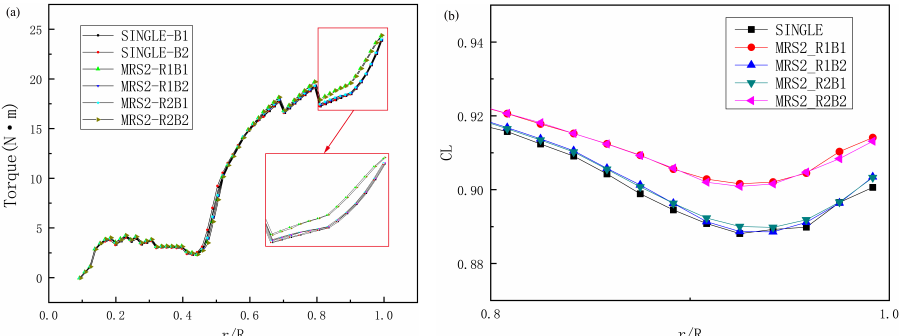
Figure 8. Comparison of torque and CL of single- and twin-rotor wind turbines in blade spreading direction: ( a ) Torque; and ( b ) CL.